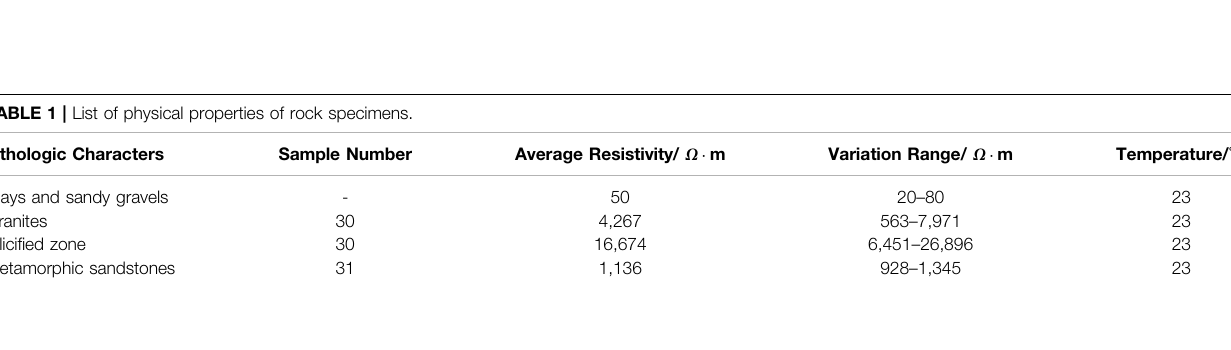
FIGURE 1| Geological sketch and borehole layout ofthe Qutan areain Jinggangshan. (A) is derived from the literature (Wang et al., 2013). (B) belongs to the local large-scale geological map.